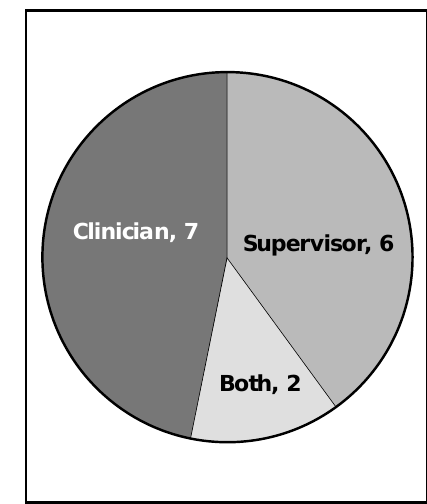
Figure 1: Capacity in which the participants were involved in student education (n=15).